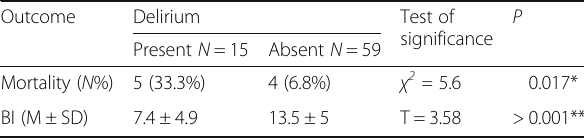
Table 6 Relationship between incidence of delirium